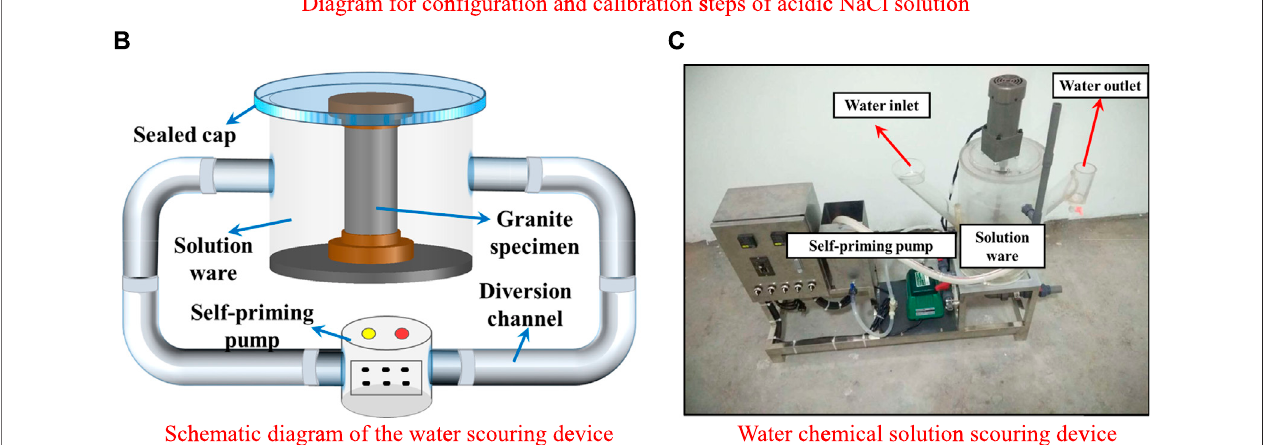
Frontiers in Earth Science |